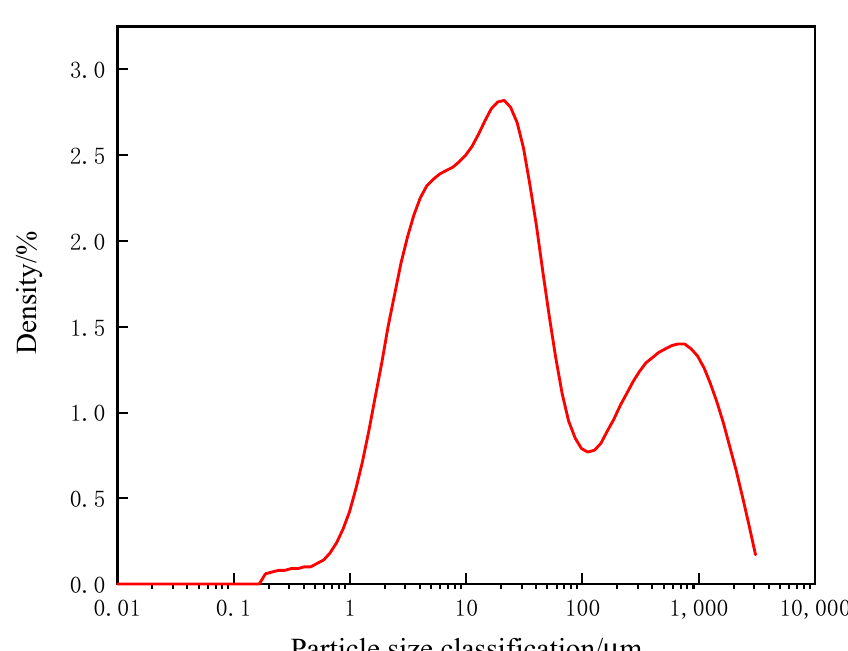
Figure 2. Raw material particle size.